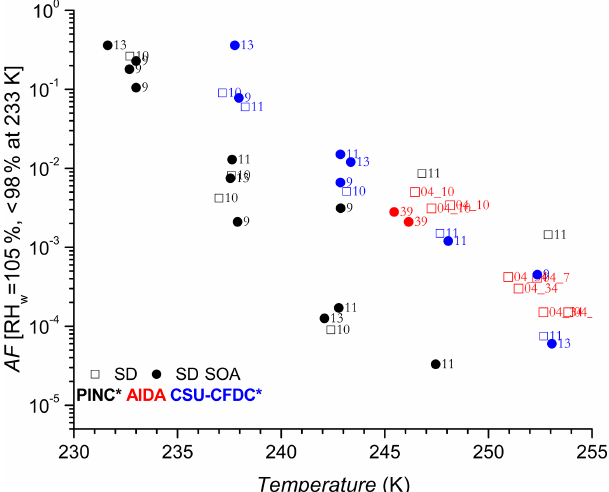
Figure 5. Same as Fig. 4, but for Saharan dust (SD) and SD coated with SOA (SD SOA)